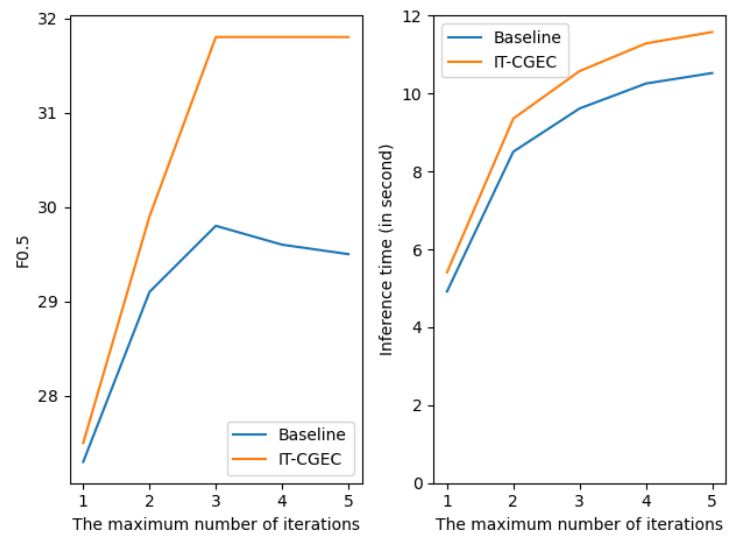
Figure 7. F0.5 measure and inference time for baseline and CGEC-IT using different maximum numbers of